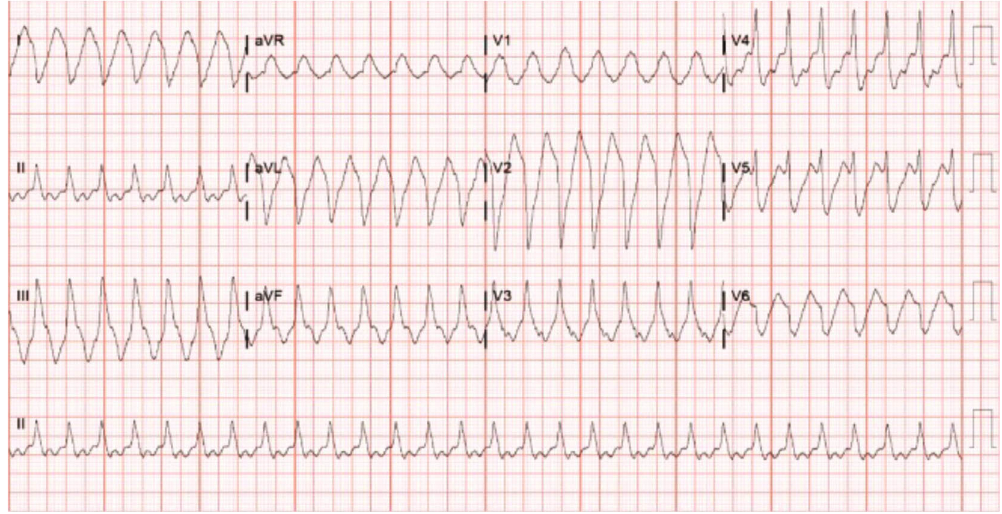
Figure 1: Presenting 12-lead electrocardiogram.